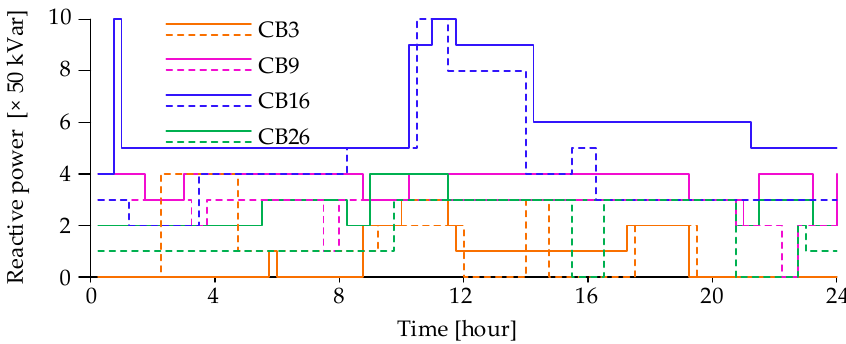
Figure 5. Day-ahead scheduled reactive power output of CBs.